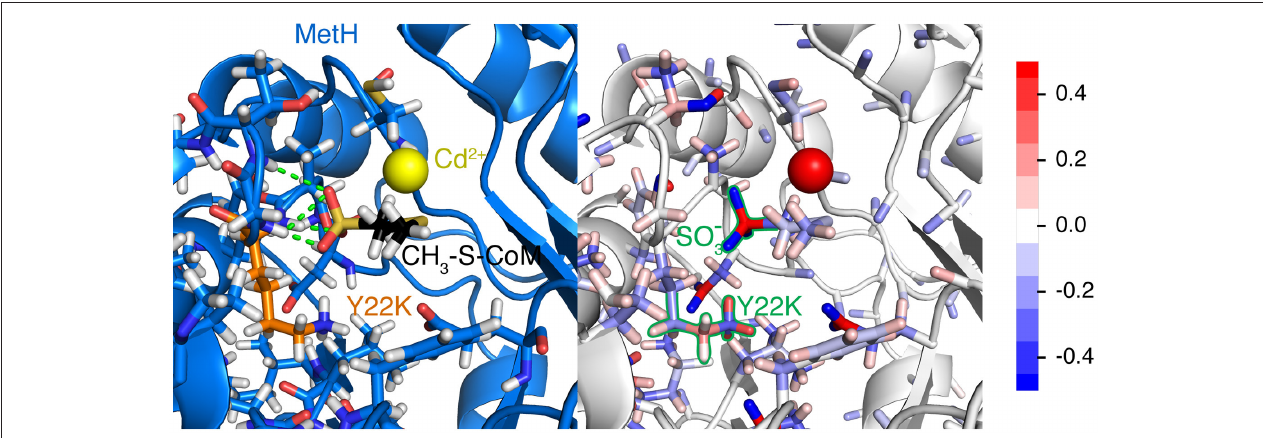
FIGURE 9 | Y22K substitution observed in each of the top five variants for CS4. The (Left) panel depicts the hydrogen bonds (green) formed between the Mcr backbone and the sulfonate group. Mcr is shown as a blue cartoon, with active site residues colored by element and represented by sticks. Y22K and CH 3 -S-CoM are also shown as sticks with their carbon atoms colored orange and black, respectively. The cadmium ion in the active site is shown as a yellow sphere. The (Right) panel shows the same representation of the active site, but atoms are instead colored by partial charge. It is evident that there is a strong negative charge of the sulfonate group and a positive charge of the Y22K (keeping in mind that the positive charge is distributed amongst the H atoms). The scale for the color scheme is shown on the far right of the figure.